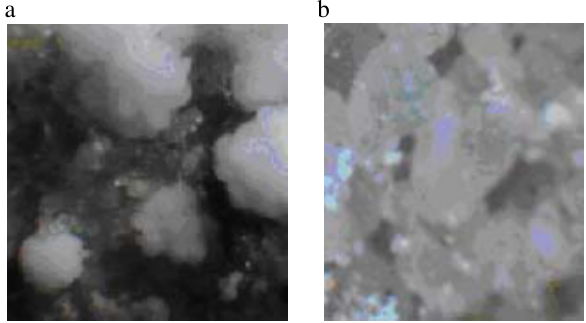
Fig 4. Surface roses formed by halite on another sand- stone block, with nitrates in subbase, arch 9 (6x magni- fied, photo by M. Gregerová) (a); higher concentrations of nitrates on sandstone block, arch 9 (12x magnified, photo by M. Gregerová) (b)